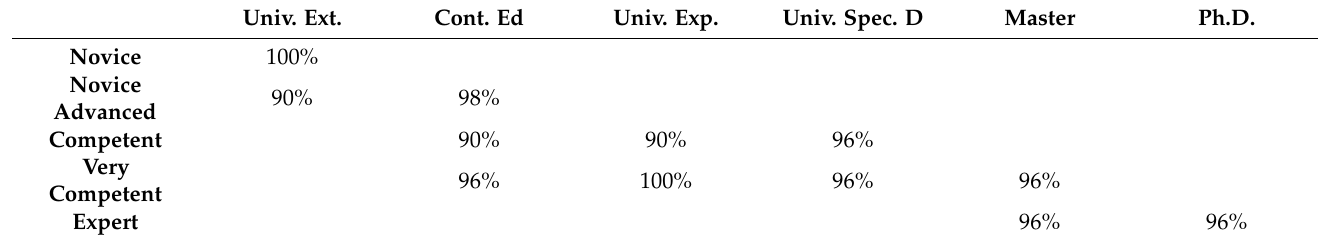
Table 3. Level of competency development and training. Univ.